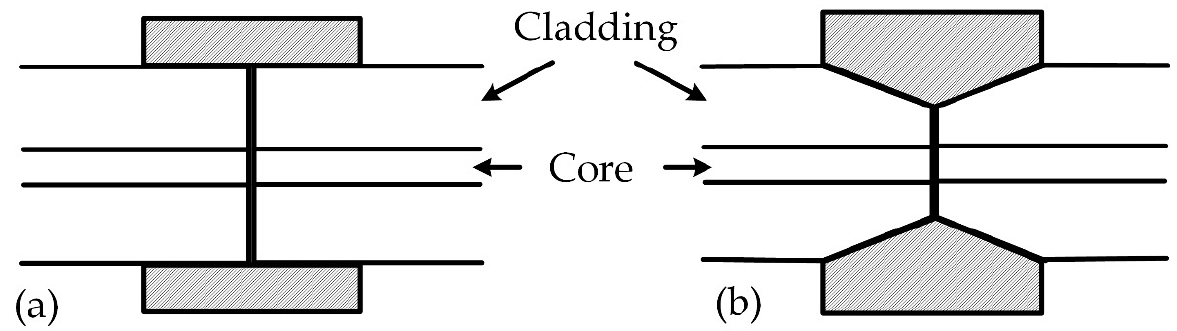
Figure 15. Schematic view of two popular aligning units of optical connectors: ( a ) cylindrical and ( b ) biconical.